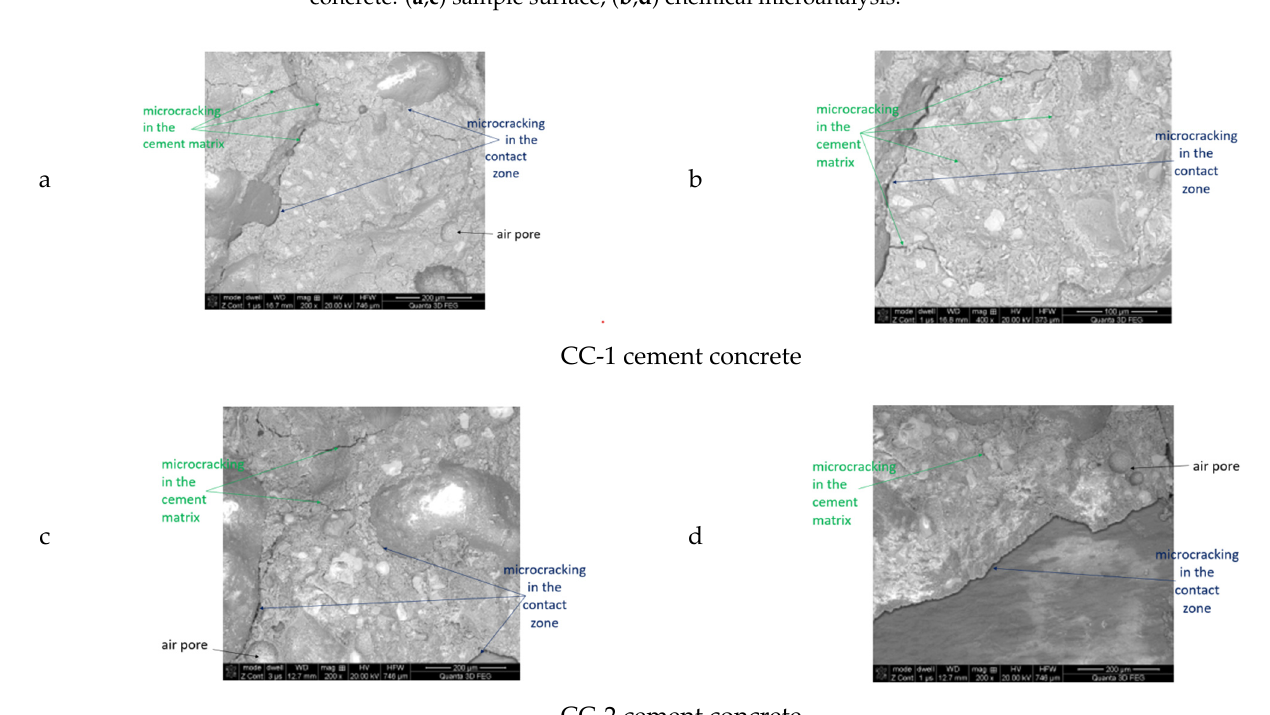
Figure 23. Construction of the internal structure of concrete subjected to thermal cycles according to scheme B for CC-1 and CC-2 concrete: ( a , c ) cement matrix, ( b , d ) contact zone between the cement matrix and the aggregate grain.